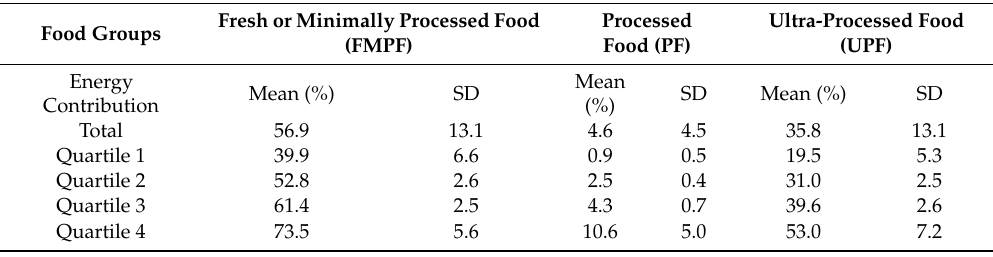
Table 3. Energy contribution of separate food groups stratified by the NOVA classification of adolescents from S ã o Lu í s, Maranh ã o, Brazil, 2016 Food Groups